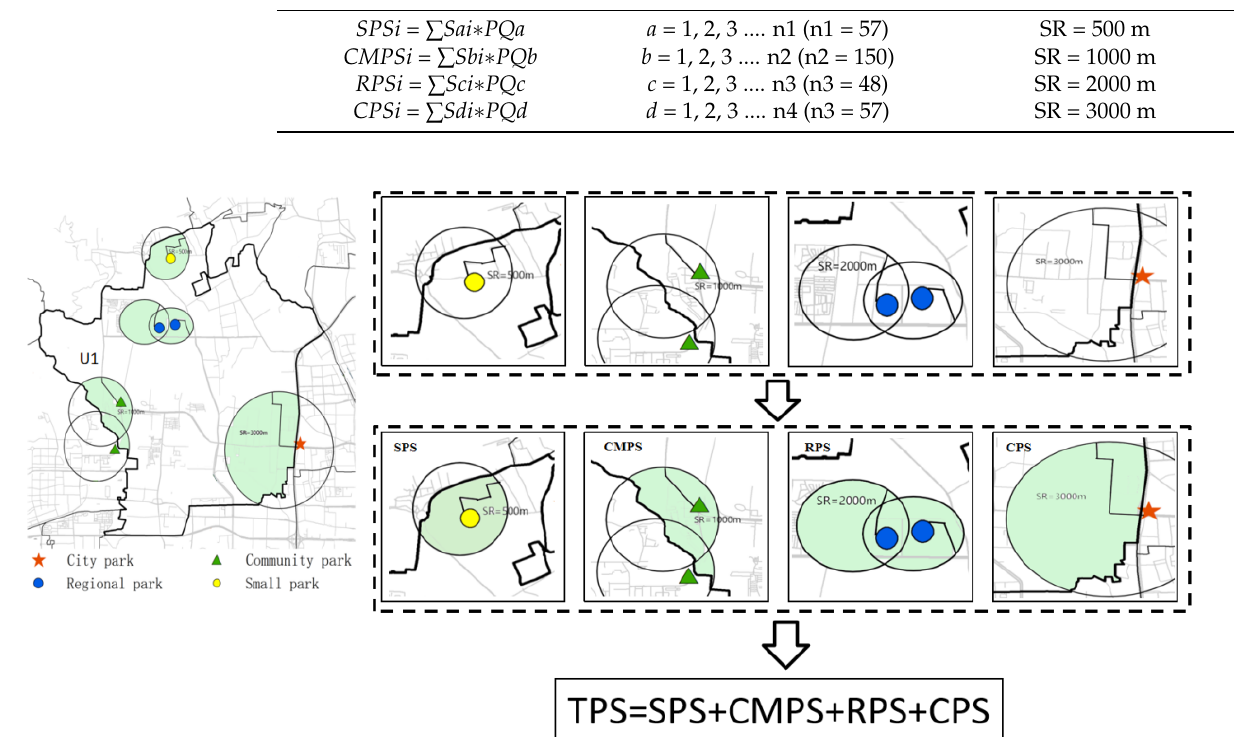
Figure 3. An example of the calculation of the total supply of UPGS within the Sijiqing sub-district.